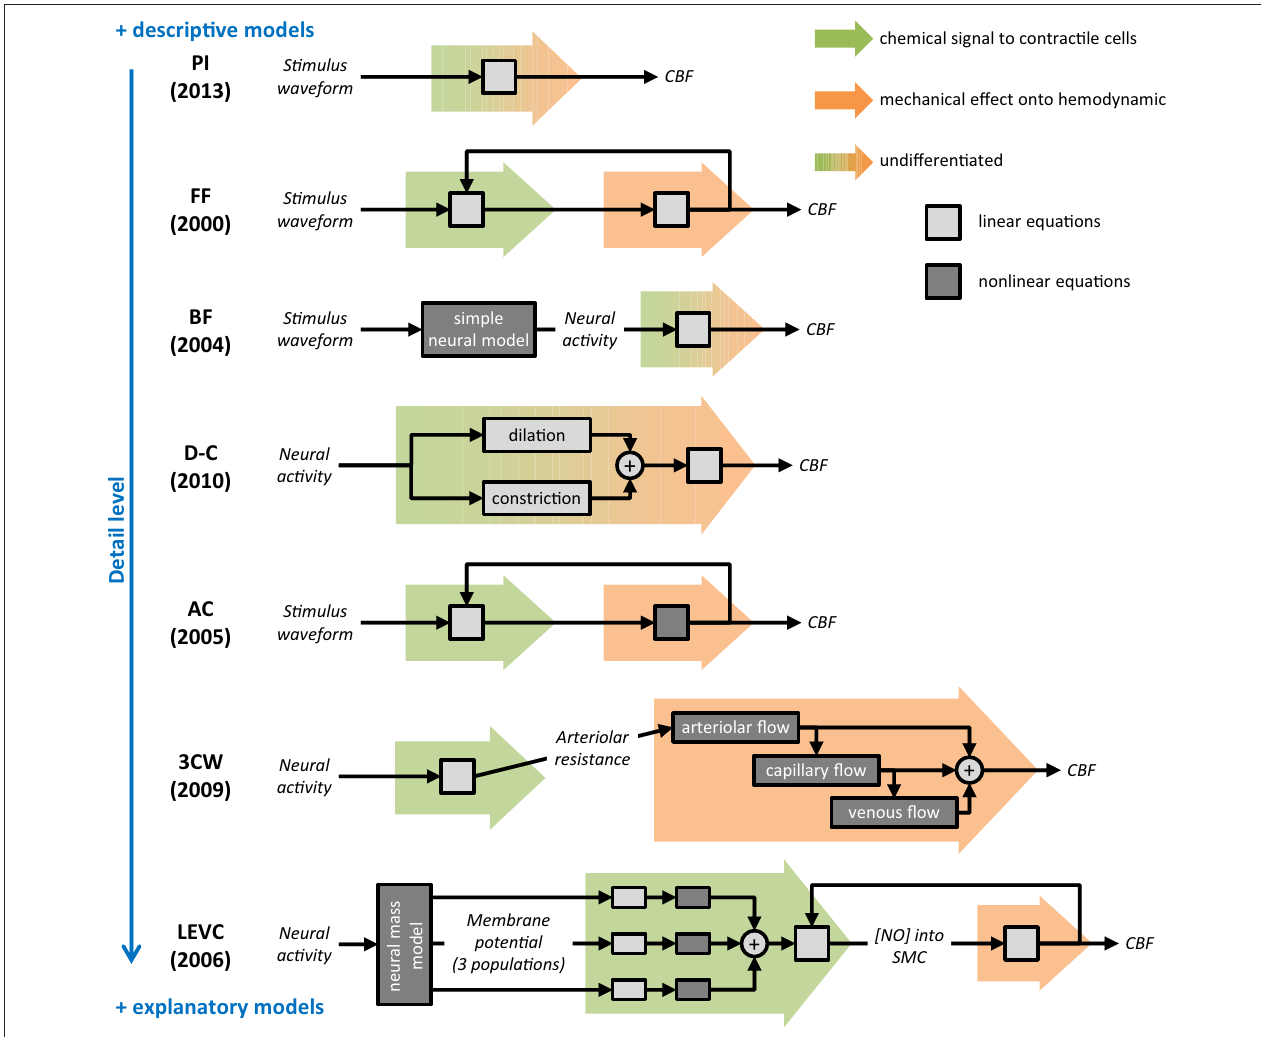
FIGURE 3 | Summary and comparison of selected dynamic models of neurovascular coupling. As for the rest of this review, only the neurovascular coupling compartment is considered. For each model, a schematic represents the mathematical process proposed to calculate the output cerebral blood flow (CBF) from the input (stimulus waveform or neural activity). Background colored arrows refer to the two steps of NVC described in Figure 2 : chemical signal from neurons/glia to contractile cells (green) and mechanical effect onto hemodynamic (orange). Boxes indicate either underlying equations are linear (light gray) or not (dark gray), and report the overall mathematical complexity. On the right, blue scale orders models regarding their detail level. Selected model names: PI, proximal integration; FF, Friston flow; BF, Buxton flow; D-C, dilation-constriction; AC, arteriolar compliance; 3CW, 3 compartments Windkessel; LEVC, local electro-vascular